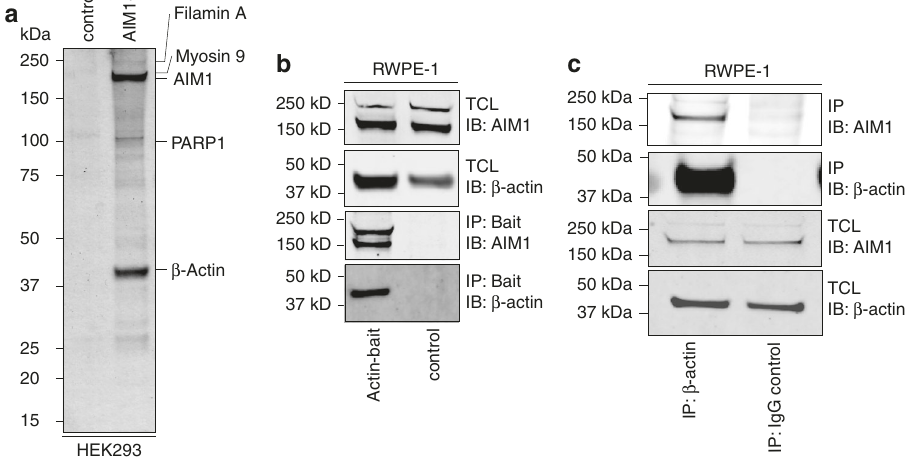
Fig. 1 AIM1 interacts with the actin cytoskeleton. Lysates from HEK293 cells transiently transfected with control or biotin-af fi nity-tagged AIM1 vectors from a single experiment were enriched by streptavidin beads. Co-precipitating complexes were eluted and eluates were separated by PAGE or analyzed by mass-spectrometry. a Representative image of a silver-stained gel of control and AIM1 biochemical enrichment experiments. Note the strong enrichment of a 42 kDa protein representing β -actin. b Endogenous AIM1 interacts with af fi nity-tagged β -actin in normal prostate epithelial cells (RWPE-1). Representative gel of three independent experiments is shown. c Pulldown of endogenous β -actin shows robust co-precipitation of AIM1 in RWPE-1 cells. Two percent of TCL was loaded as control. IB immunoblot, IP immunoprecipitate, TCL total cell